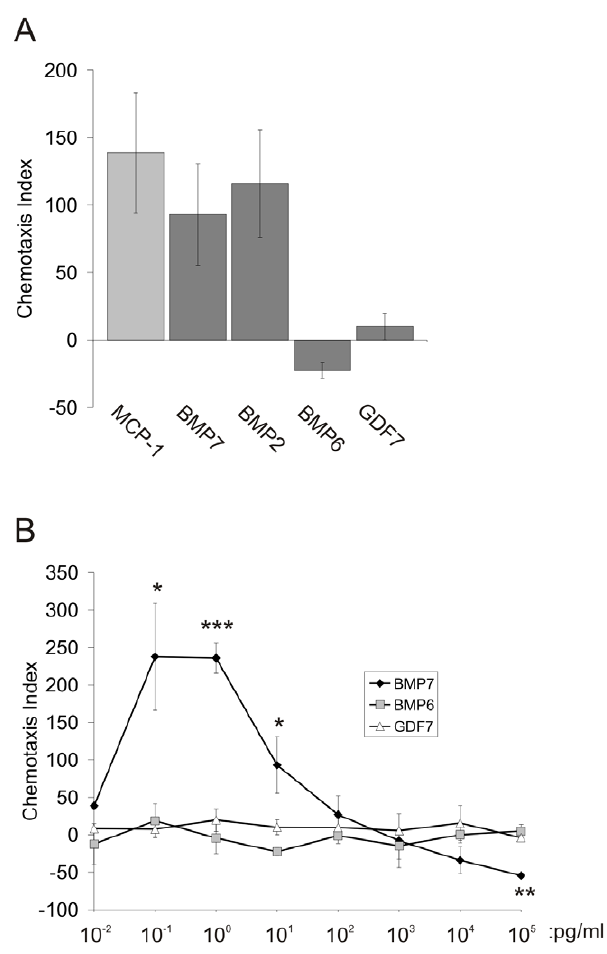
Figure 1. Chemotaxis of monocytic cells in response to a panel of BMPs. A: WEHI 274.1 cell migration through transwell chamber filters in response to 10 pg/ml BMP7, BMP2, BMP6 or GDF7 in the lower chamber. For comparison, cells were also stimulated with MCP-1 (100 ng/ml). The chemotaxis index (CI) is shown as mean + / 2 SEM. MCP-1 (CI= 139 + / 2 45, n= 4); BMP7 (CI= 93 + / 2 38, n=5); BMP2 (CI=116 + / 2 40, n=4); BMP6 (CI= 2 23 + / 2 6, n=3); GDF7 (CI=10 + / 2 10, n=3). B: Dose response curves for chemotaxis of WEHI 274.1 cells in response to BMP7, BMP6 and GDF7 (n $ 3 for each protein at each concentration). Migration in the presence of BMP7 differs